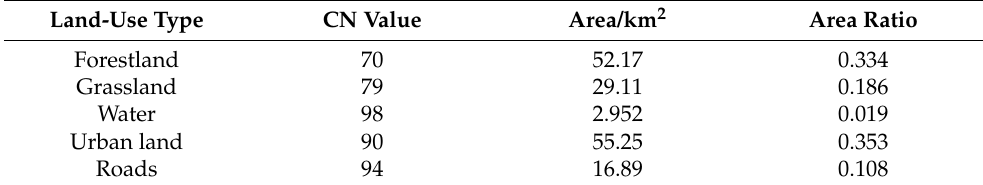
Table 1. Supervision Classification Calculation